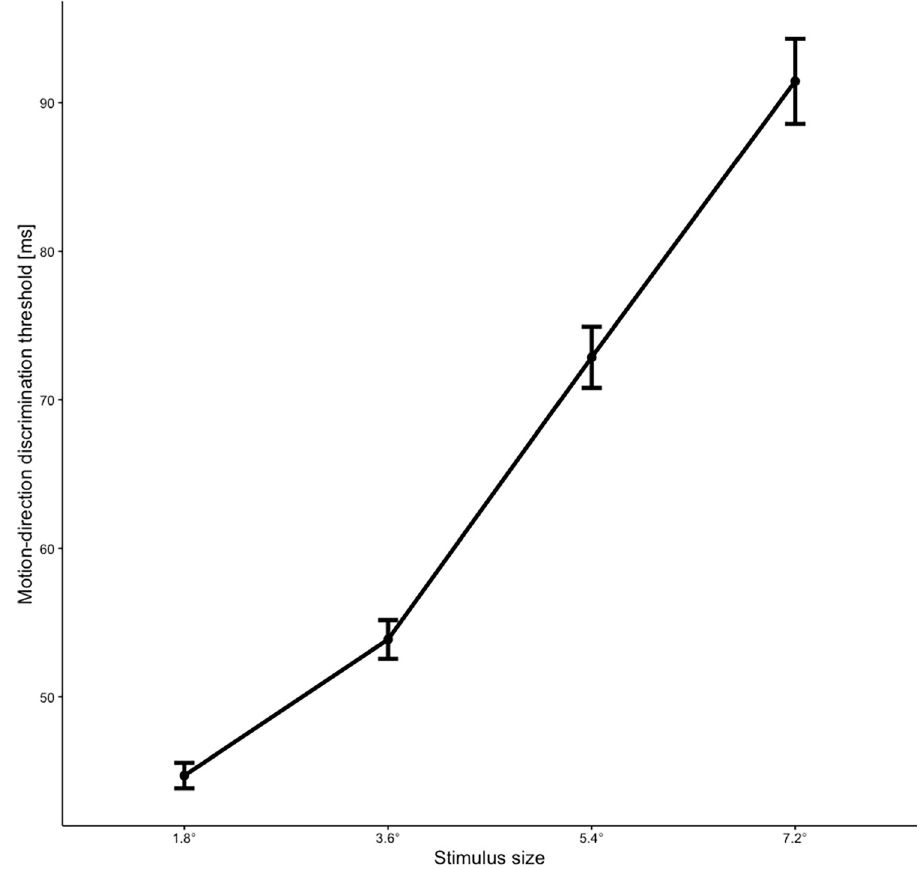
Fig 1. Line plot of the mean thresholds concerning the four conditions in the spatial suppression task. The mean per condition (stimulus size, in ms) and its standard errors are presented for 273 participants. For better illustration, the raw values of the presented mean thresholds were each multiplied by 2.5